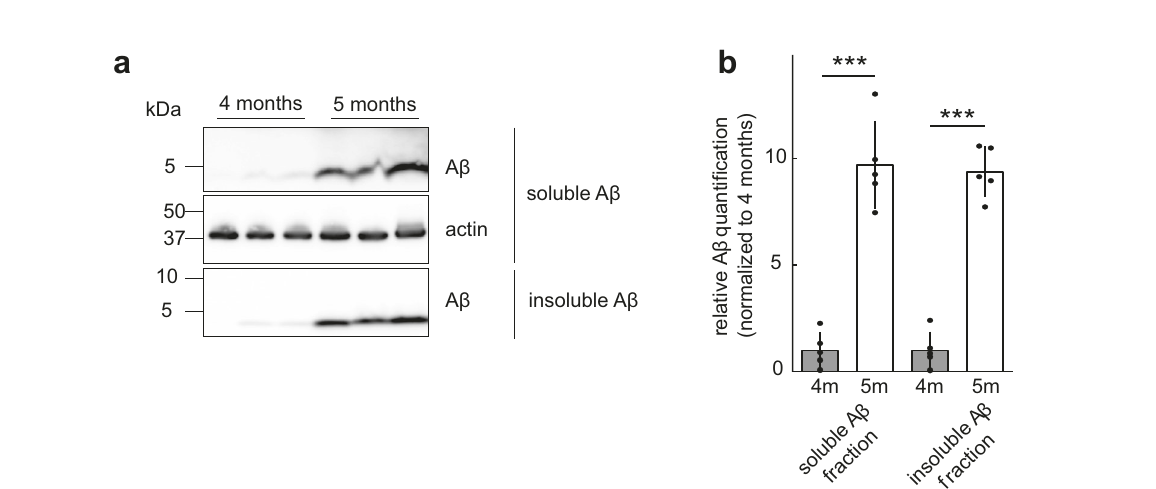
Fig. 2 A β load in 4 and 5 months old APPPS1 mice. a Western blot analysis of soluble (STET, p < 0.001) and insoluble (FA, p < 0.001, unpaired two-tailed Student ’ s t test) A β fractions of APPPS1 mice. b Quanti fi cation of A β Western blot signals demonstrates a signi fi cant increase of A β load from 4 to 5 months of age (9.7- and 9.4-fold in the soluble and insoluble fraction, respectively,). Values are normalized to the values of A β at 4 months and represent the mean ± SEM. *** p <